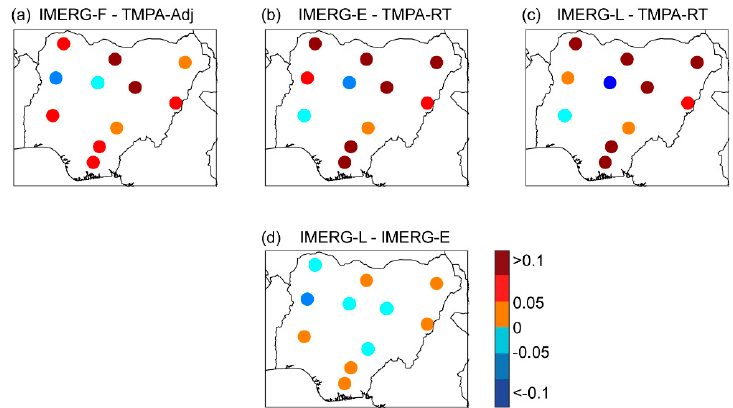
Figure 9. Comparative display of TRMM and GPM product performance at the gauge locations by comparing TRMM-TMPA vs. GPM-IMERG. ( a ) The performance of IMERG-F v.6 with TMPA-Adj v.7, ( b ) IMERG-E v.6 with TMPA-RT V.7, ( c ) IMERG-L v.6 with TMPA-RT v.7, ( d ) IMERG-L v.6 with IMERG-E v.6 at rain gauge points.